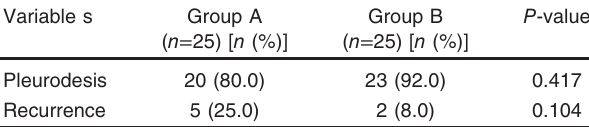
Table 5 Rate of successful pleurodesis and recurrence of effusion in groups A and